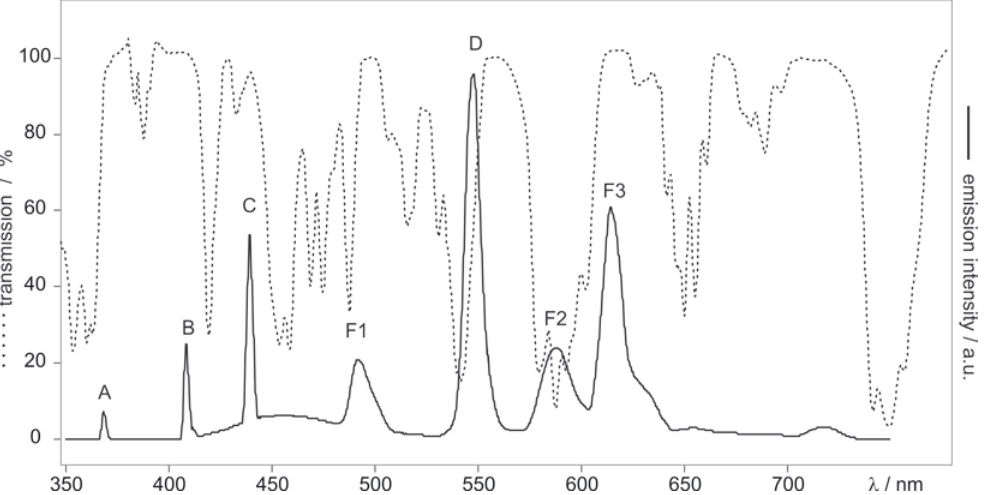
Figure 4. Ho,Nd:YAB transmission spectrum (dashed) and fluorescence lamp “840” energy distribution (solid line). A to D are mercury “I” emis - sion lines, F1, F2 and F3 stem from the fluorescence of the lamp